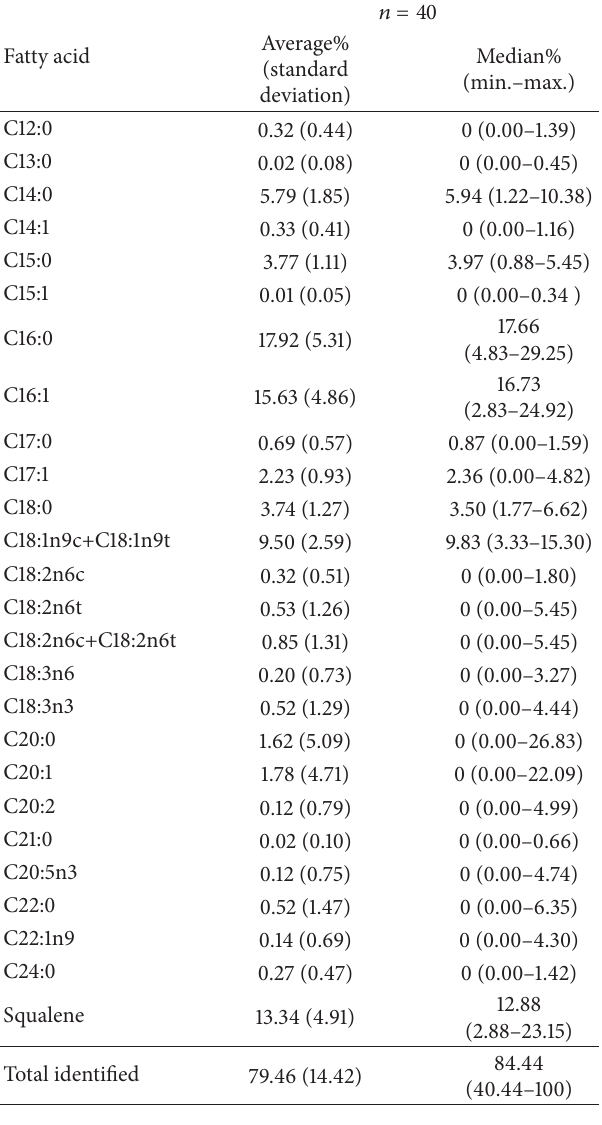
Table 1: Distribution of patients with acne vulgaris according to the outcome of gas chromatography carried out on